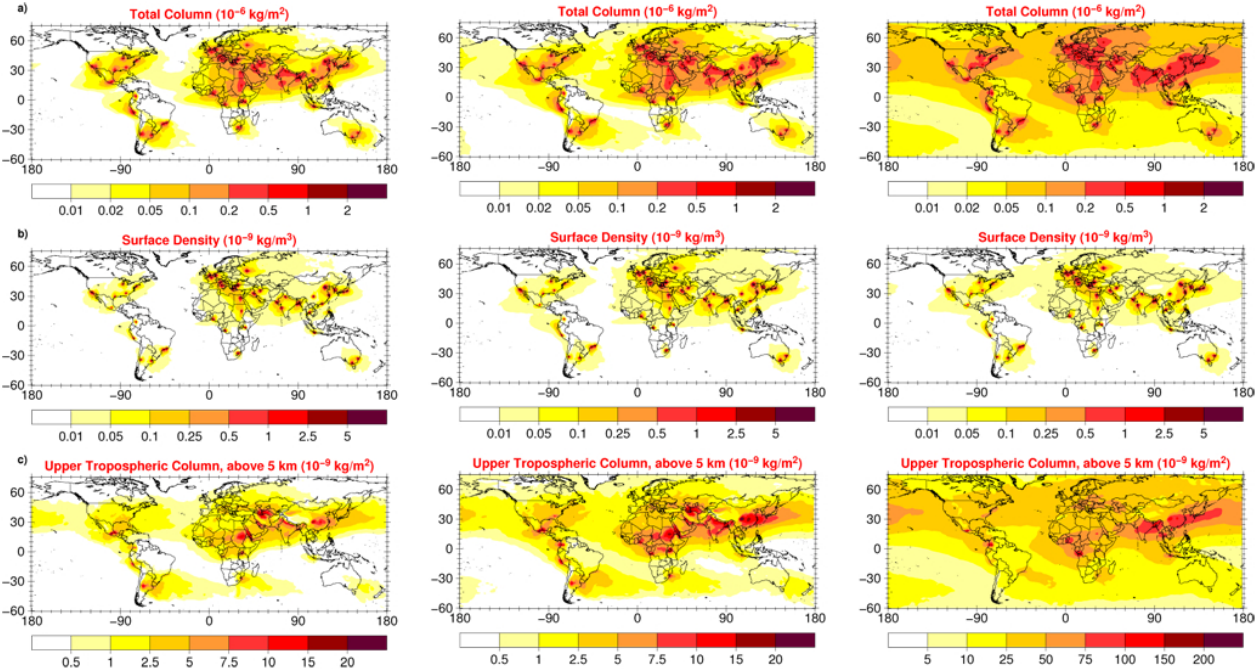
Fig. 3. Total column densities (top panel), surface densities (middle panel), and upper tropospheric column densities (bottom panel) for the sum of all 46 MPC tracer sources from the EMAC simulations. Left and central columns show the NS inact and NS act 1.0µm aerosol tracers and the right column the gas-phase tracers with a 10d decay lifetime. Units are 10 − 6 kgm − 2 for total column densities, 10 − 9 kgm − 3 for the surface densities, and 10 − 9 kgm − 2 for the upper tropospheric column densities. Please note the different color-scaling, by a factor of ten, for the upper tropospheric column densities between the aerosol and gas-phase